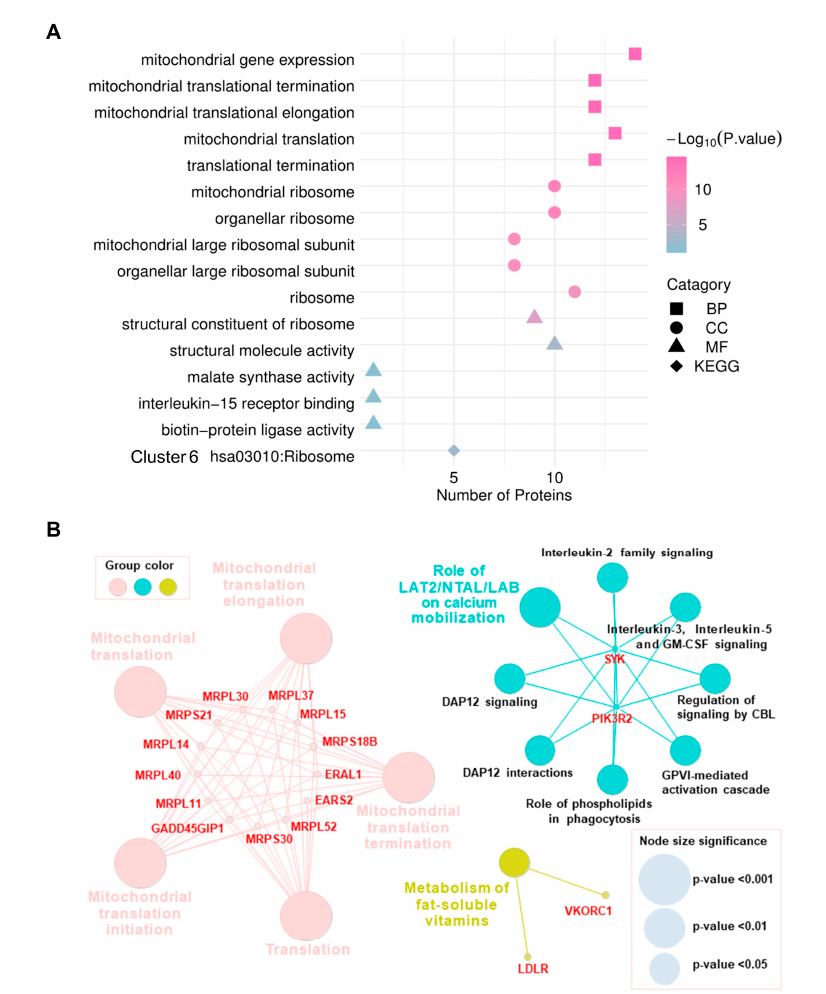
Figure 4. Functional enrichment analysis of common DEPs between HCT116 and DLD1 cells. ( A ) Gene Ontology (GO) and Kyoto Encyclopedia of Genes and Genomes (KEGG) pathway analysis of common DEPs between HCT116 and DLD1 cell lines. Analysis of categories include biological processes (BP), cellular component (CC), molecular function (MF), and Kyoto Encyclopedia of Genes and Genomes (KEGG). ( B ) Reactome pathway analysis of common DEPs between HCT116 and DLD1 cell lines; the gradual change of size from large to small stands for the p -values from low to